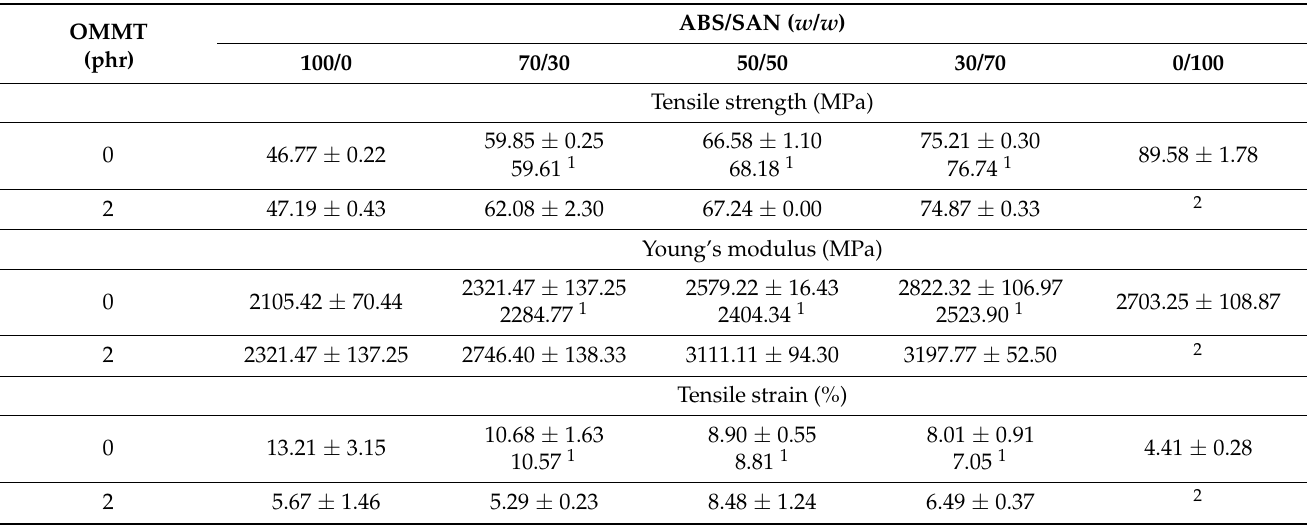
Table 5. Tensile properties of ABS/SAN blends and their